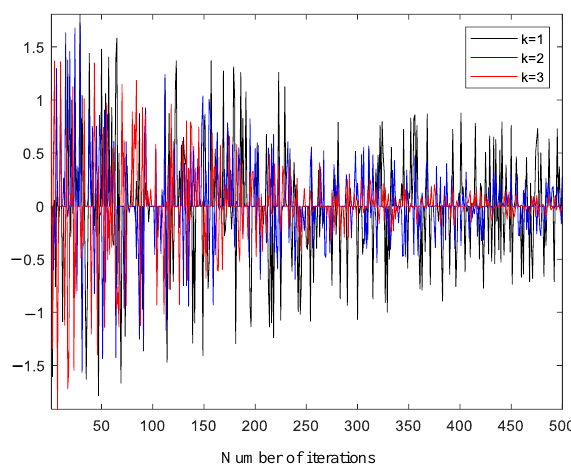
Figure 4. The original rG iteration curve.